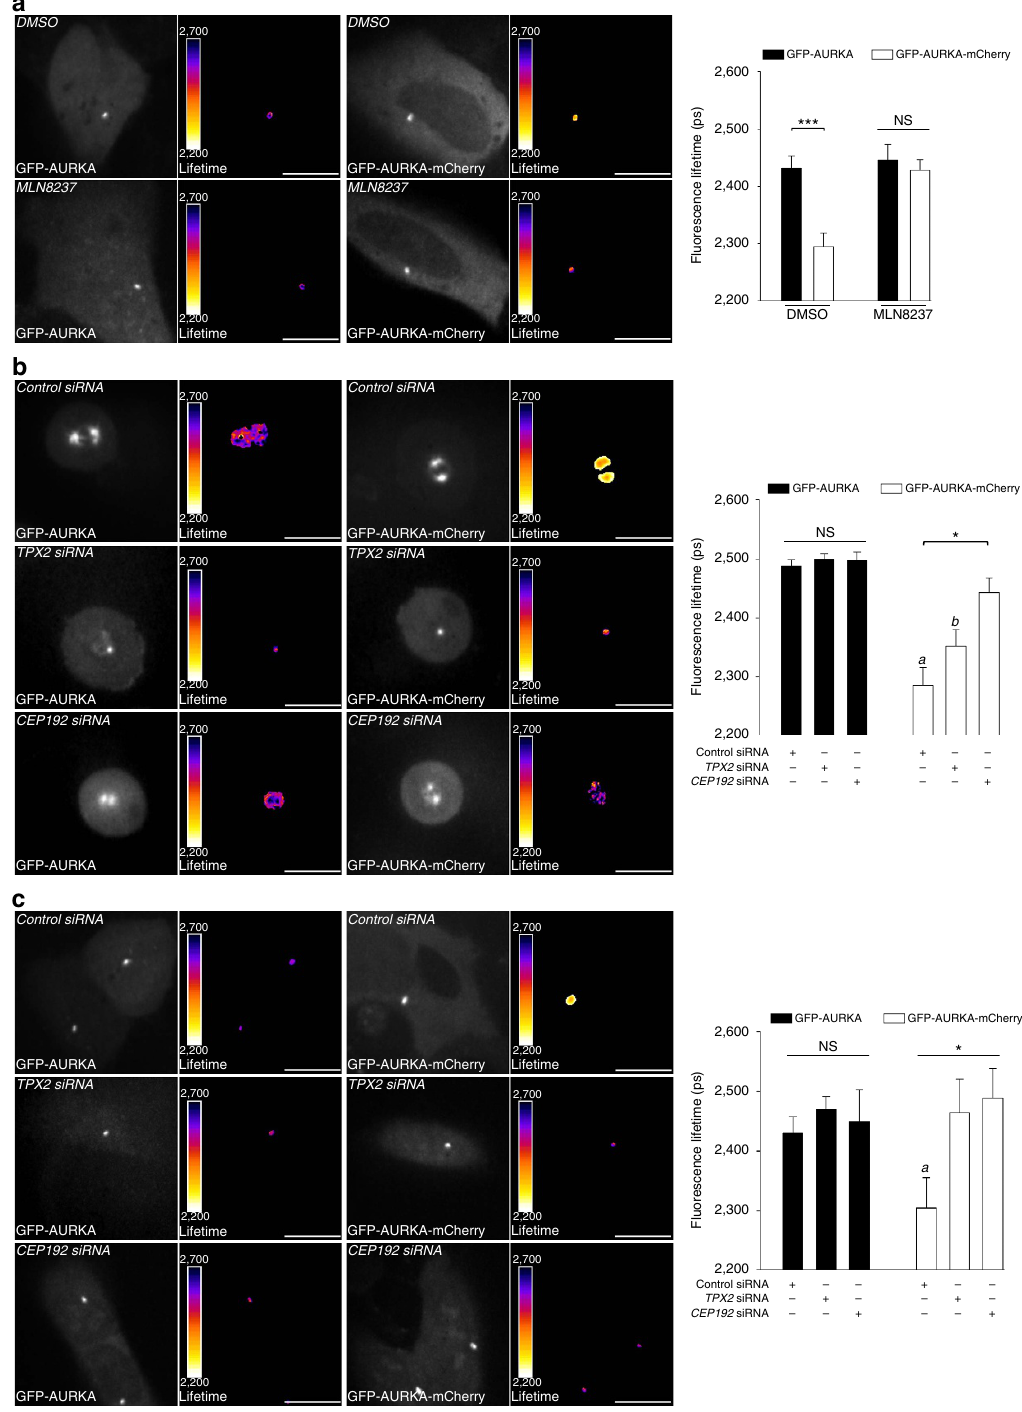
Figure 6 | TPX2 and CEP192 are required for the activation of the AURKA biosensor during the G1 phase. ( a ) (Left panels) Representative fluorescence (GFP channel) and lifetime images of GFP-AURKA and GFP-AURKA-mCherry cells synchronized in G1 and treated with dimethylsulfoxide (DMSO) or with MLN8237. (Right panel) Quantification of the lifetime of EGFP at the centrosomes of GFP-AURKA and GFP-AURKA-mCherry cells synchronized in G1 and treated as in the corresponding left panels. n ¼ 10–15 cells per condition from one experiment representative of three. ( b ) (Left and middle panels) Representative fluorescence (GFP channel) and lifetime images of GFP-AURKA or of GFP-AURKA-mCherry cells transfected with a control, a TPX2 - or a CEP192 -specific siRNA and synchronized at mitosis. (Right panel) Corresponding lifetime quantification. n ¼ 10–15 cells per condition from one experiment representative of three. ( c ) Images and quantification performed as in b , on cells synchronized in G1 and depleted for TPX2 or CEP192 . n ¼ 10–15 cells per condition from one experiment representative of three. Data represent means ± s.e.m. Pseudocolour scale: pixel-by-pixel lifetime. Scale bar, 10 m m. *** P o 0.001 against the corresponding ‘GFP-AURKA’ condition in a , * P o 0.05 against the ‘ CEP192 siRNA’ condition within the GFP-AURKA-mCherry paradigm and a P o 0.001 and b P o 0.01 against the corresponding ‘GFP-AURKA’ condition in b , c . NS, not significant. Statistical tests: two-way ANOVA in a ; one-way ANOVA in b , c